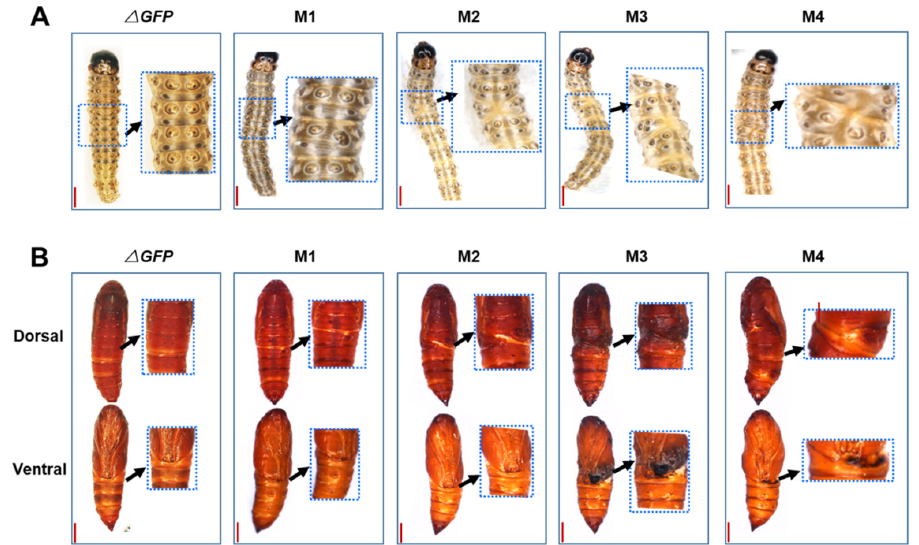
Figure 6. Segmentation malformation in OfAbd-A mutants at larval and pupal stages. ( A ) The phenotypes of OfAbd-A mutants in the larval stage. Arrows show abnormal segments. Bar = 0.3 mm. ( B ) The phenotypes of OfAbd-A mutants in the pupal stage. Arrows show abnormal segments. Bar = 0.2 mm.